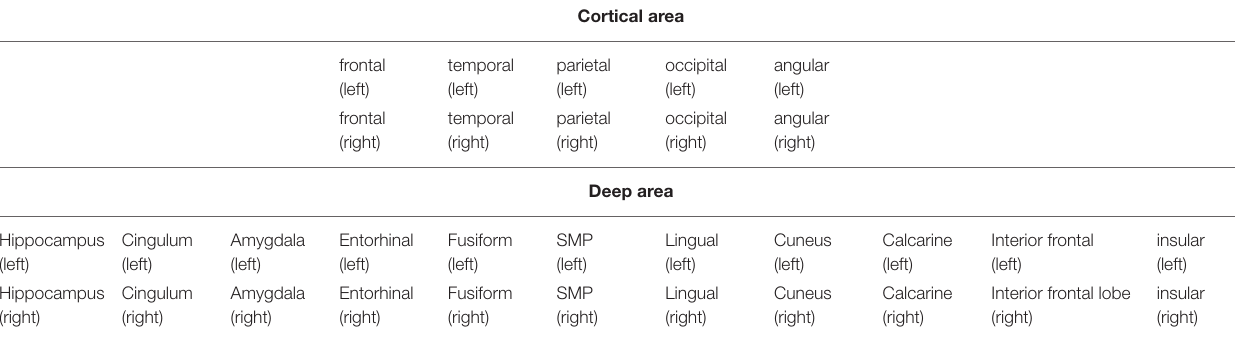
TABLE 2 | Positions of included electrodes (10 cortical areas and 22 deep